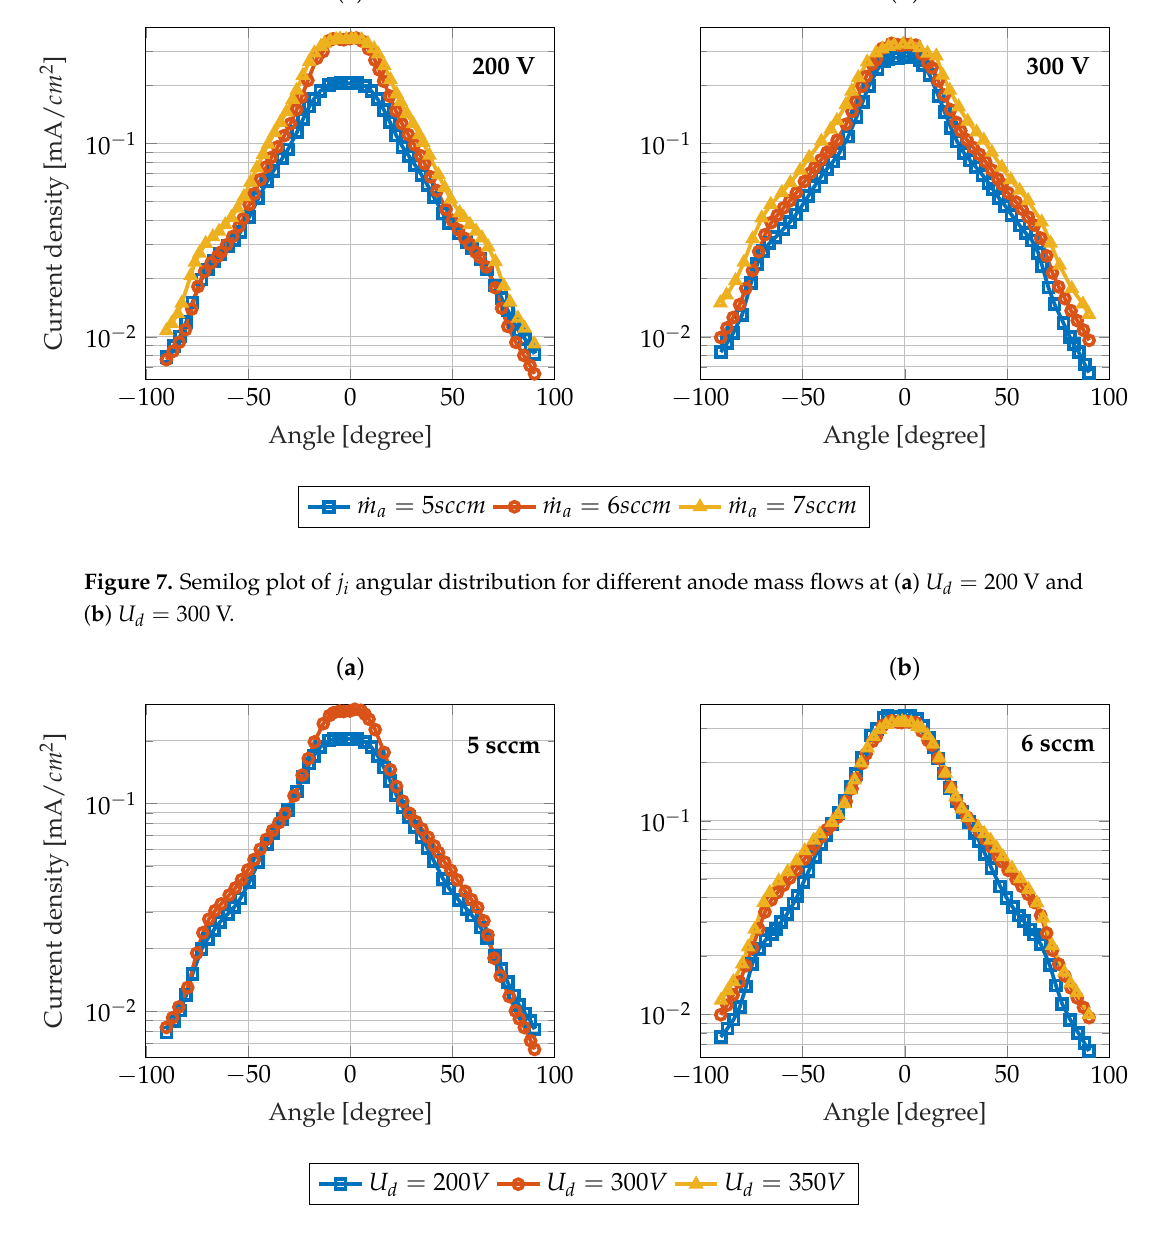
Figure 8. Semilog plot of j i angular distribution for different discharge voltages at ( a ) ˙ m a = 5 sccm and ( b ) ˙ m a = 6